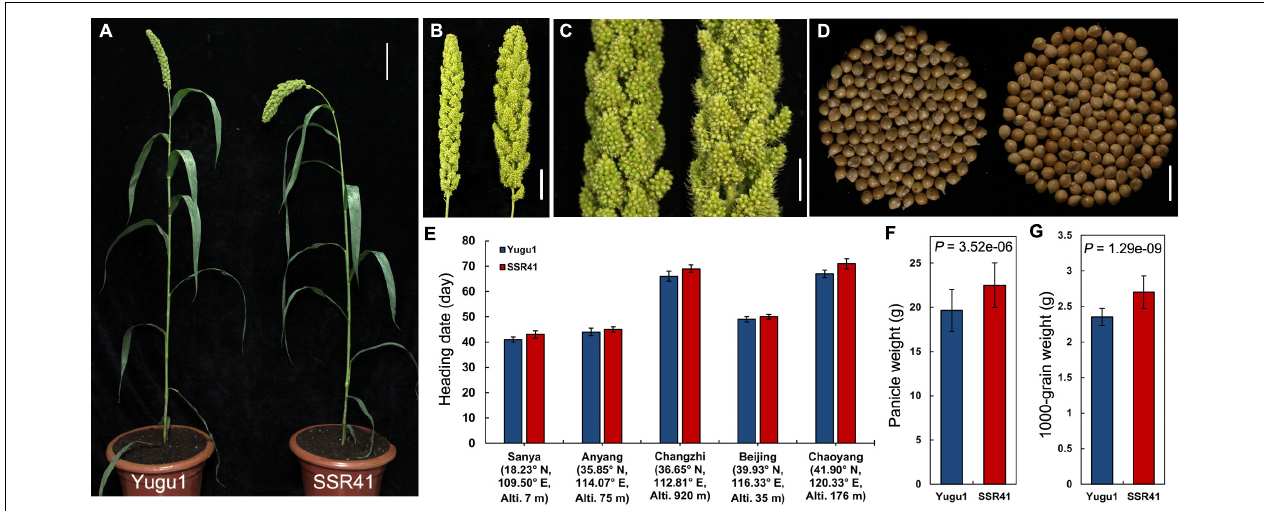
FIGURE 1 | Phenotypes and statistical comparisons between “SSR41” and “Yugu1”. (A) Phenotype of whole plants at the heading stage. Bar = 10 cm. (B) Panicle of “Yugu1” (left) and “SSR41” (right). Bar = 3 cm. (C) An enlarged view of primary branches and spikelets of “Yugu1” (left) and “SSR41” (right). Bar = 1.5 cm. (D) Seeds of “Yugu1” (left; 150 seeds) and “SSR41” (right; 150 seeds). Bar = 5 mm. (E–G) Statistical comparisons of heading date, panicle weight, and 1,000-grain weight between “Yugu1” and “SSR41”. Values are means ± SD ( n = 3 for heading date, n = 6 for panicle weight, and 1,000-grain weight). P values were determined using Student’s t